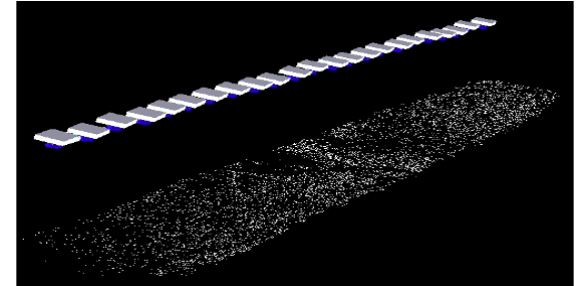
Figure 3 . An example of simulated nadir and straight UAV images.